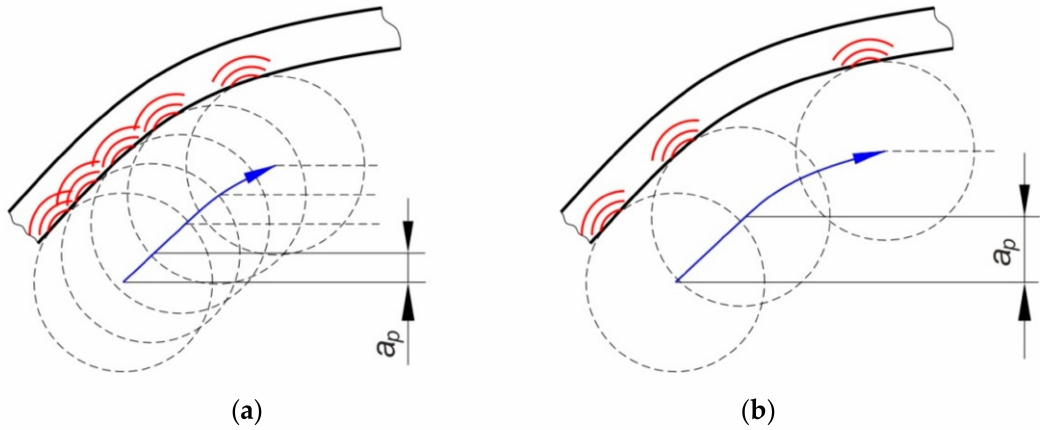
Figure 8. Effect of vertical pitch on the manner of interaction of the tool with the sheet metal at ( a ) small and ( b ) high value of vertical